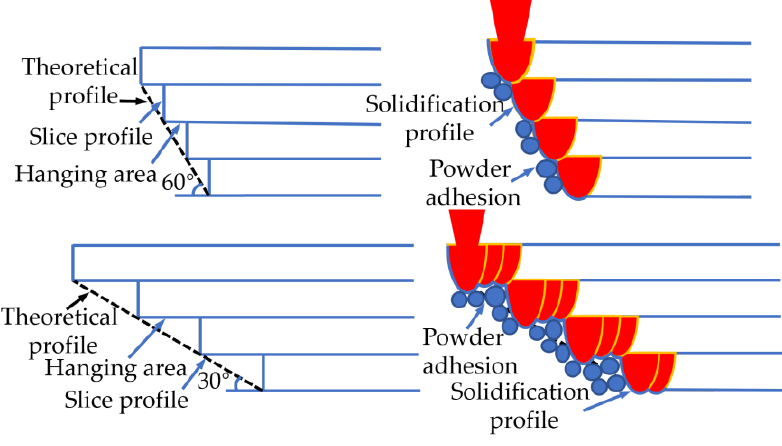
Figure 13. Diagram of forming the lower side surface topography.